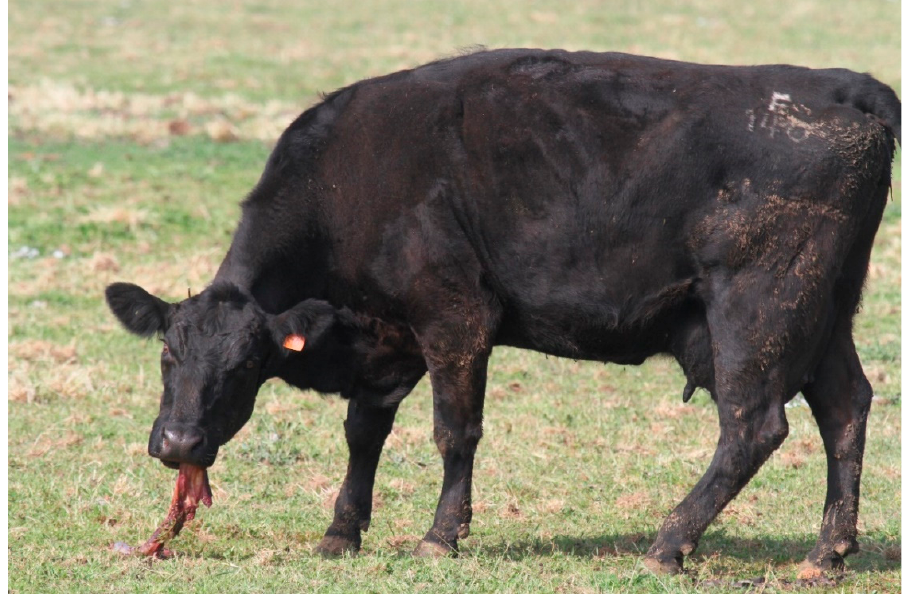
Figure 2. Postpartum cow exhibiting placentophagia